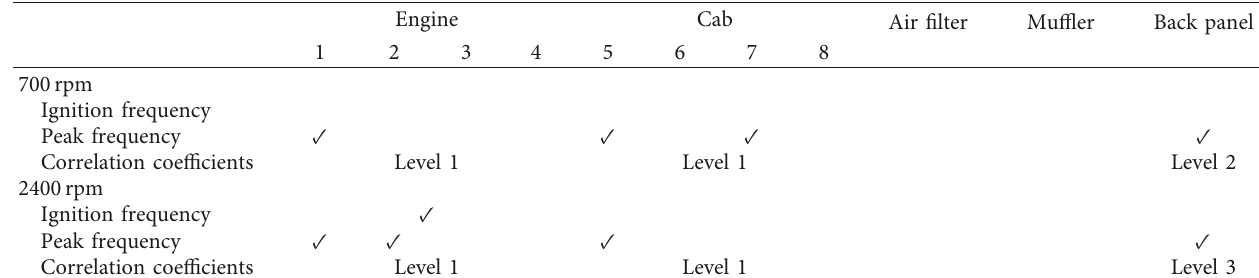
Table 5: Ontology reasoning results.